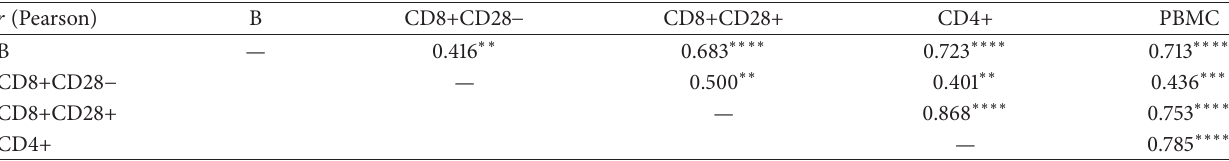
Table 3: Correlation of telomere length among different cell types at the 18-month visit ( 𝑁 = 39